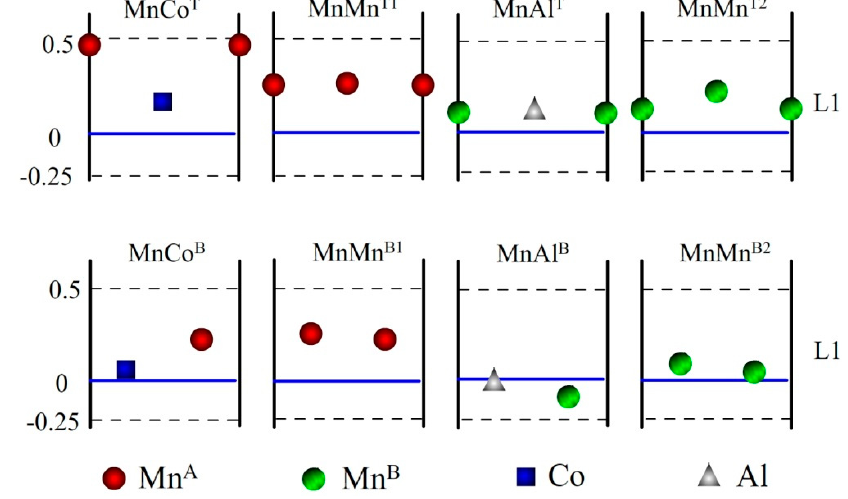
Figure 3. The relaxed atomic positions in various terminations. L1 and L2 indicate the interface and subinterface, respectively.